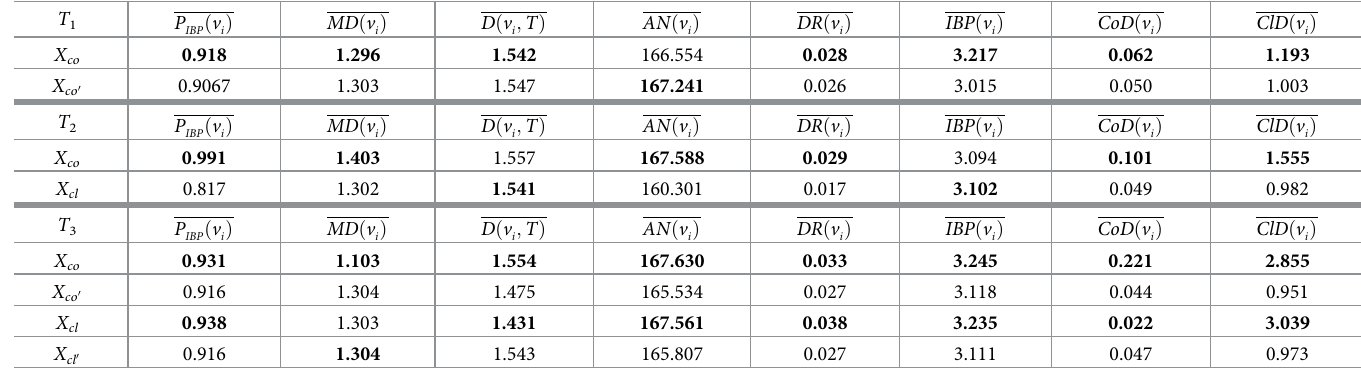
Table 3. The first column shows two groups of random sets in each selected set. The next columns show the average values obtained for each feature in each of the selected set. ( X denotes the average values).